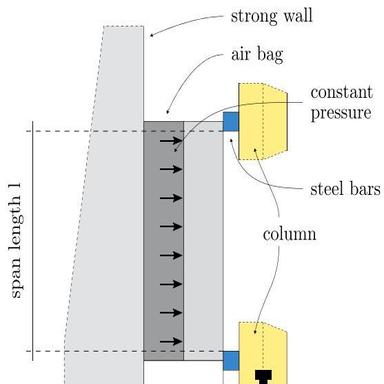
Bending test setup.